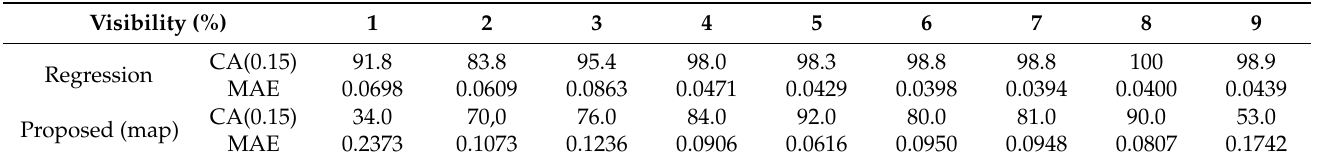
Table 9. The regression results at each level for two